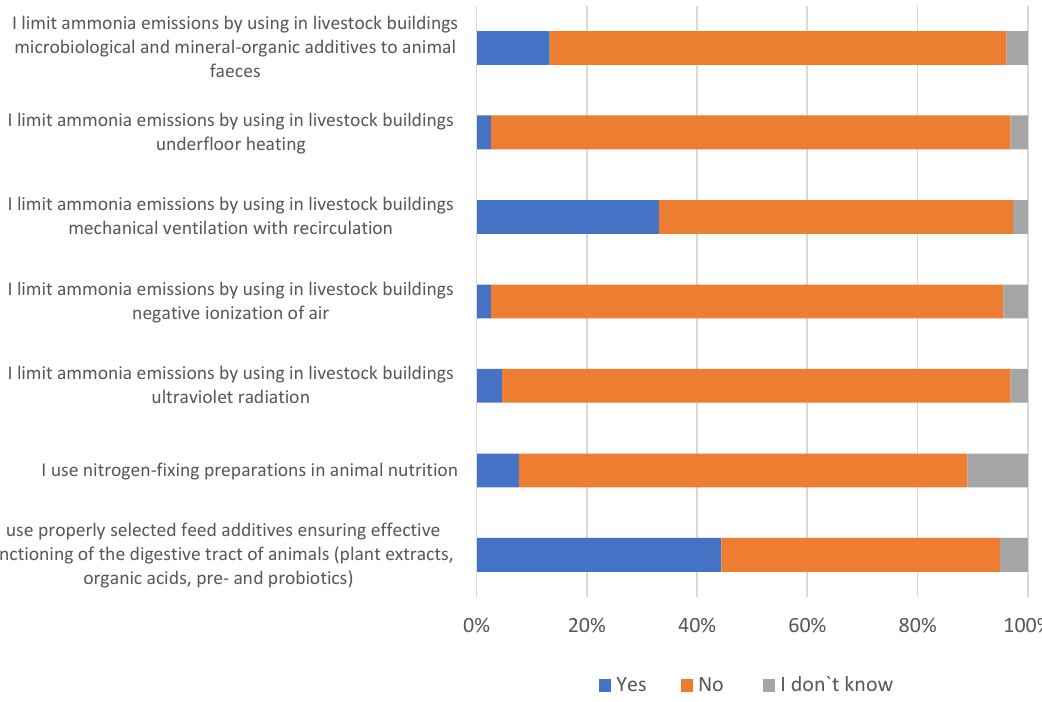
Figure 2. Declarations of respondents engaged in plant production on the methods of reducing ammonia emissions . Source: own study based on questionnaire surveys ( n = 1034)